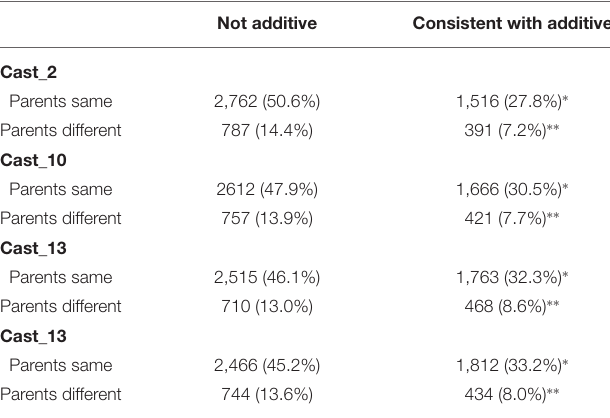
TABLE 1 | Test for additivity in polyploid expression. Not additive Consistent with additive